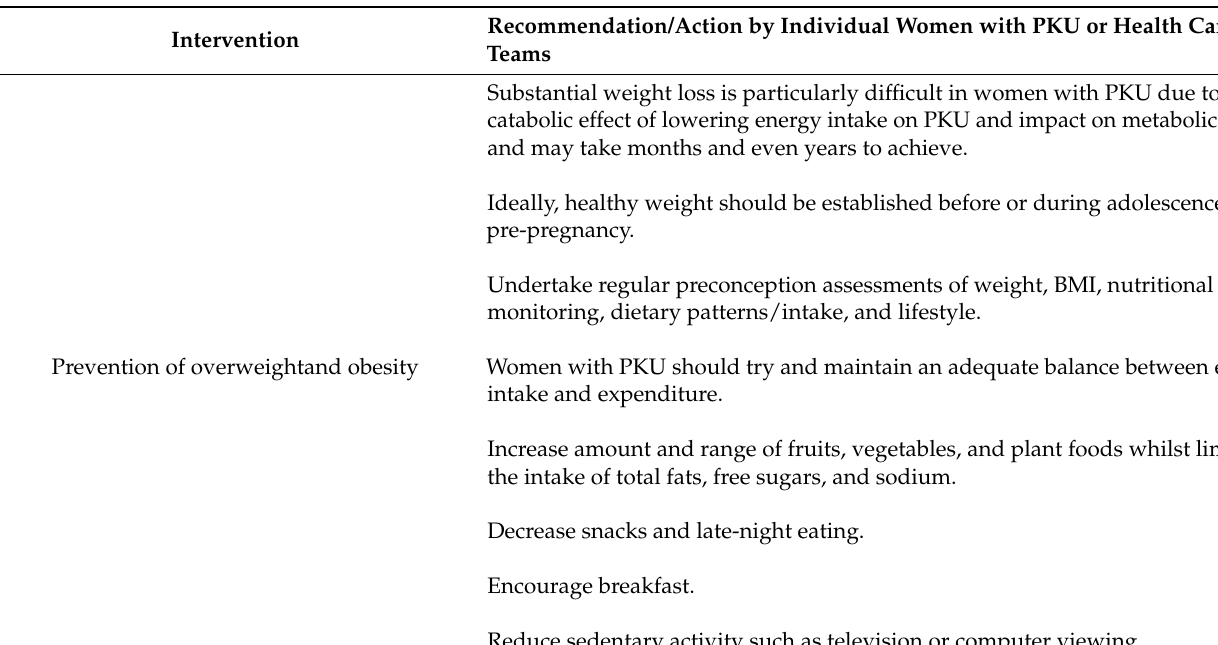
Table 1. Interventions to improve nutritional health in women with PKU in their reproductive years. Recommendation/Action by Individual Women with PKU or Health Care Intervention Teams